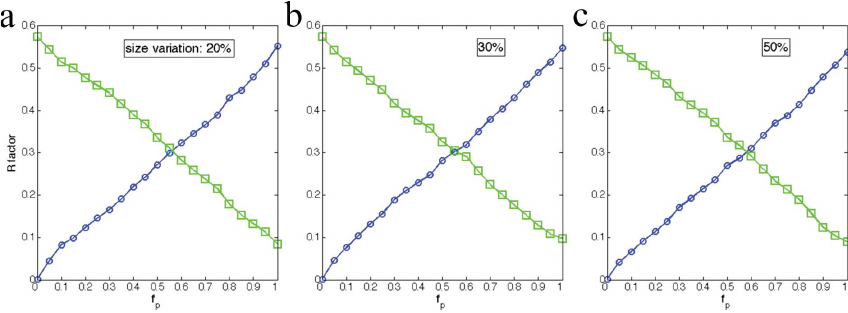
Figure 7 Crystal size variations do not affect molecular transform recovery. The crystal sizes vary 20%, 30% and 50% around the mean (10 unit cells). The variations in crystal sizes do not hinder the recovered pattern quality, indicated by the R factors compared with the theoretical patterns from default unit cell (circles) or alternative unit cell (squares). The axes are defined as in Fig. 6. Green line: original unit cell; blue line: alternate unit